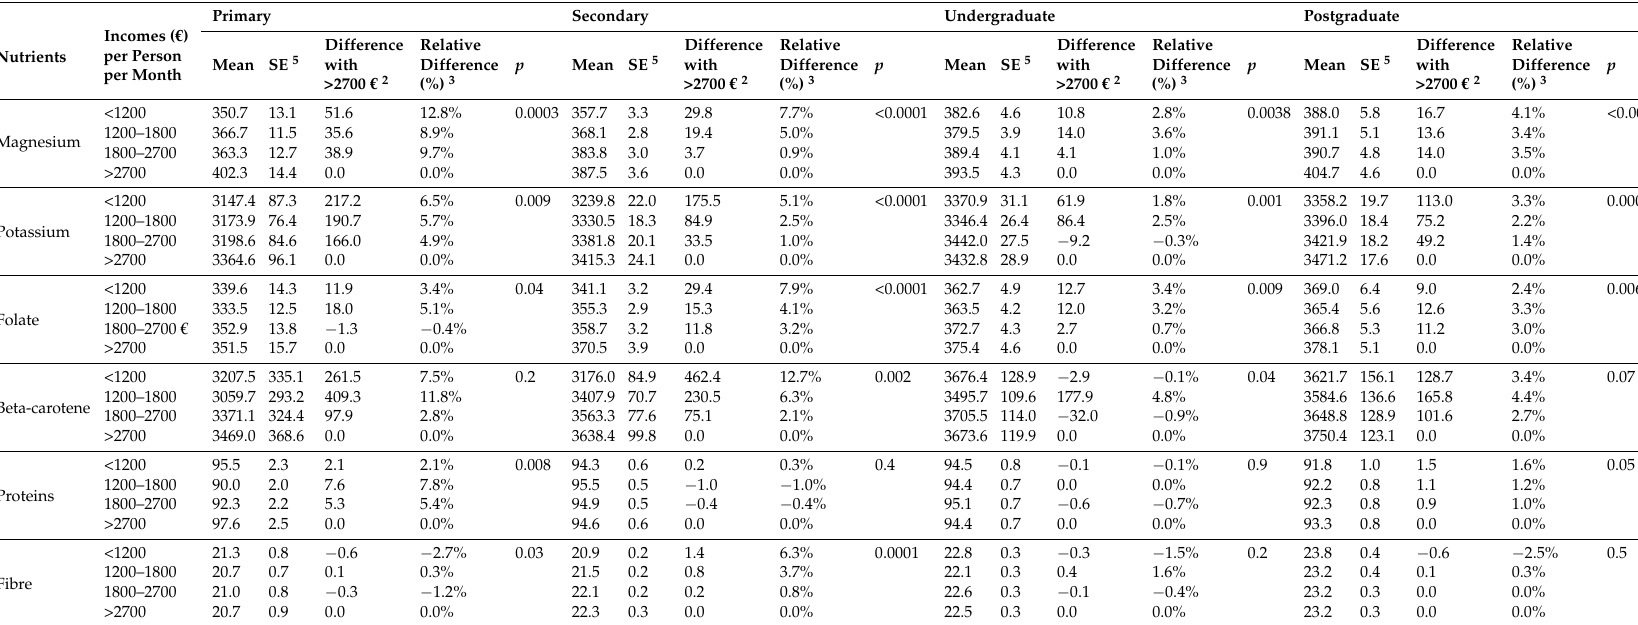
Table 5. Associations between dietary intake of magnesium, potassium, folate, beta-carotene, proteins, fibre and income stratified by educational level in men ( N = 19,746) 1,4